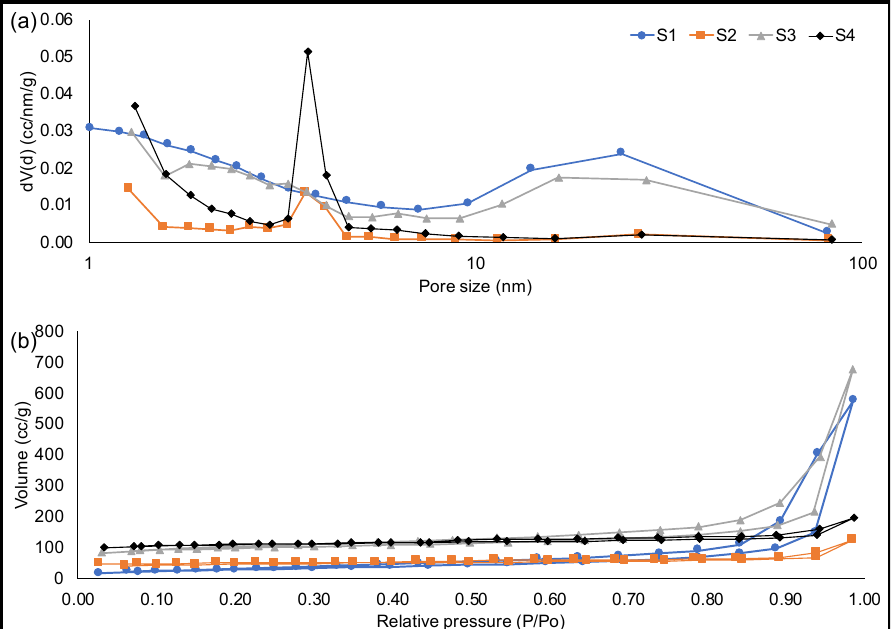
Figure 5. Plots of ( a ) adsorption–desorption isotherms and ( b ) pore size distribution for all pyrolysis solids.